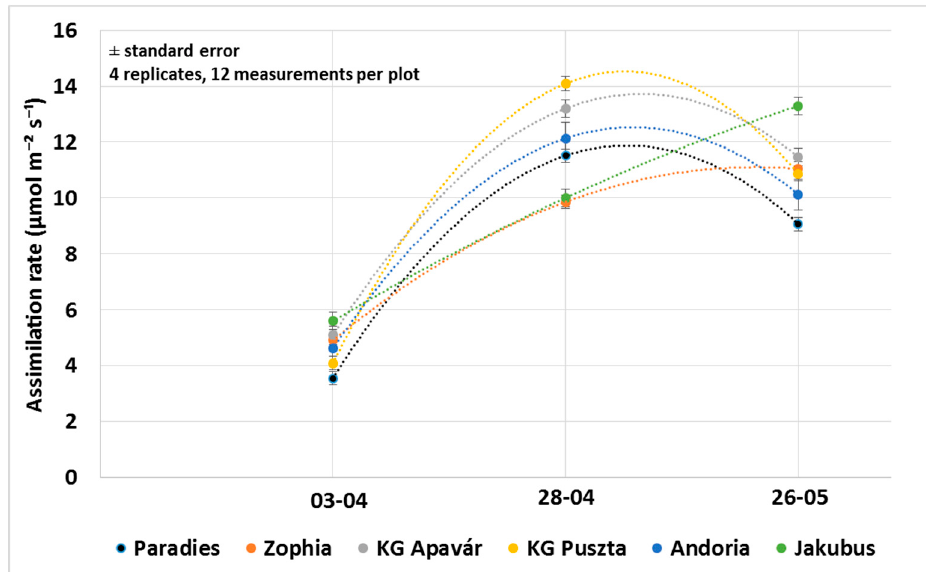
Figure 2. Assimilation rate of winter barley cultivars, (Debrecen, 2020), means of N treatments, standard error of means. 4 replicates, 12 measurements (2 leaves, 6 recordings per leaf). The assimilation rate of the winter barley cultivars changed during the growing season. The differences among the varieties were significant, p < 0.05.